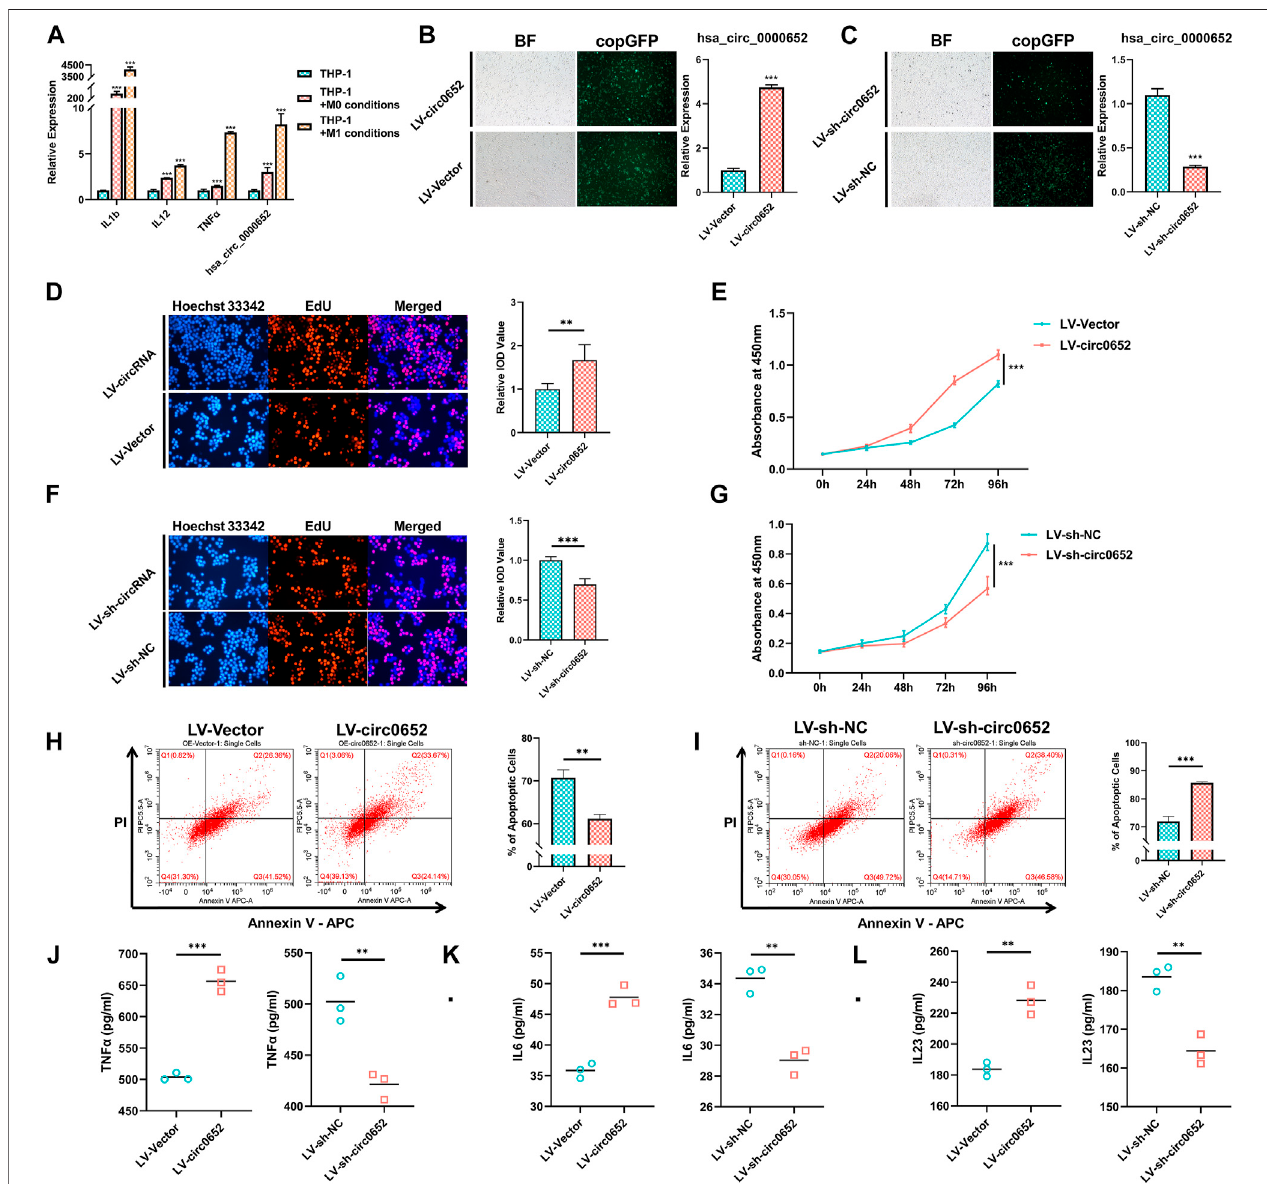
FIGURE 3 | Hsa_circ_0000652 promotes the activation of macrophages. (A) Quantitative real-time PCR (qRT-PCR) analysis of IL-1b, IL-12, TNF- α , and hsa_circ_0000652 during the activation of THP-1 – derived macrophages (n (cid:2) 3); (B – C) observation of copGFP and qRT-PCR analysis in hsa_circ_0000652 stably expressed THP-1 cell lines; (D – G) 5-ethynyl-2 ′ -deoxyuridine (EdU) assay and cell counting kit-8 (CCK-8) assay after overexpression and knockdown of hsa_circ_0000652; (H – I) Annexin V – PI assay determined the apoptotic cell ratio of THP-1 – derived macrophages with overexpression and knockdown of hsa_circ_0000652 (n (cid:2) 3); (J – L) ELISA of cytokine levels in the culture medium of THP-1 – derived macrophages with overexpression and knockdown of hsa_circ_0000652 (n (cid:2) 3). Data in bar plots and line plots are presented as mean ± SD, and data in scatter plots are supplemented with line of mean. ** p < 0.01; *** P < 0.001. Each experiment was performed at least in